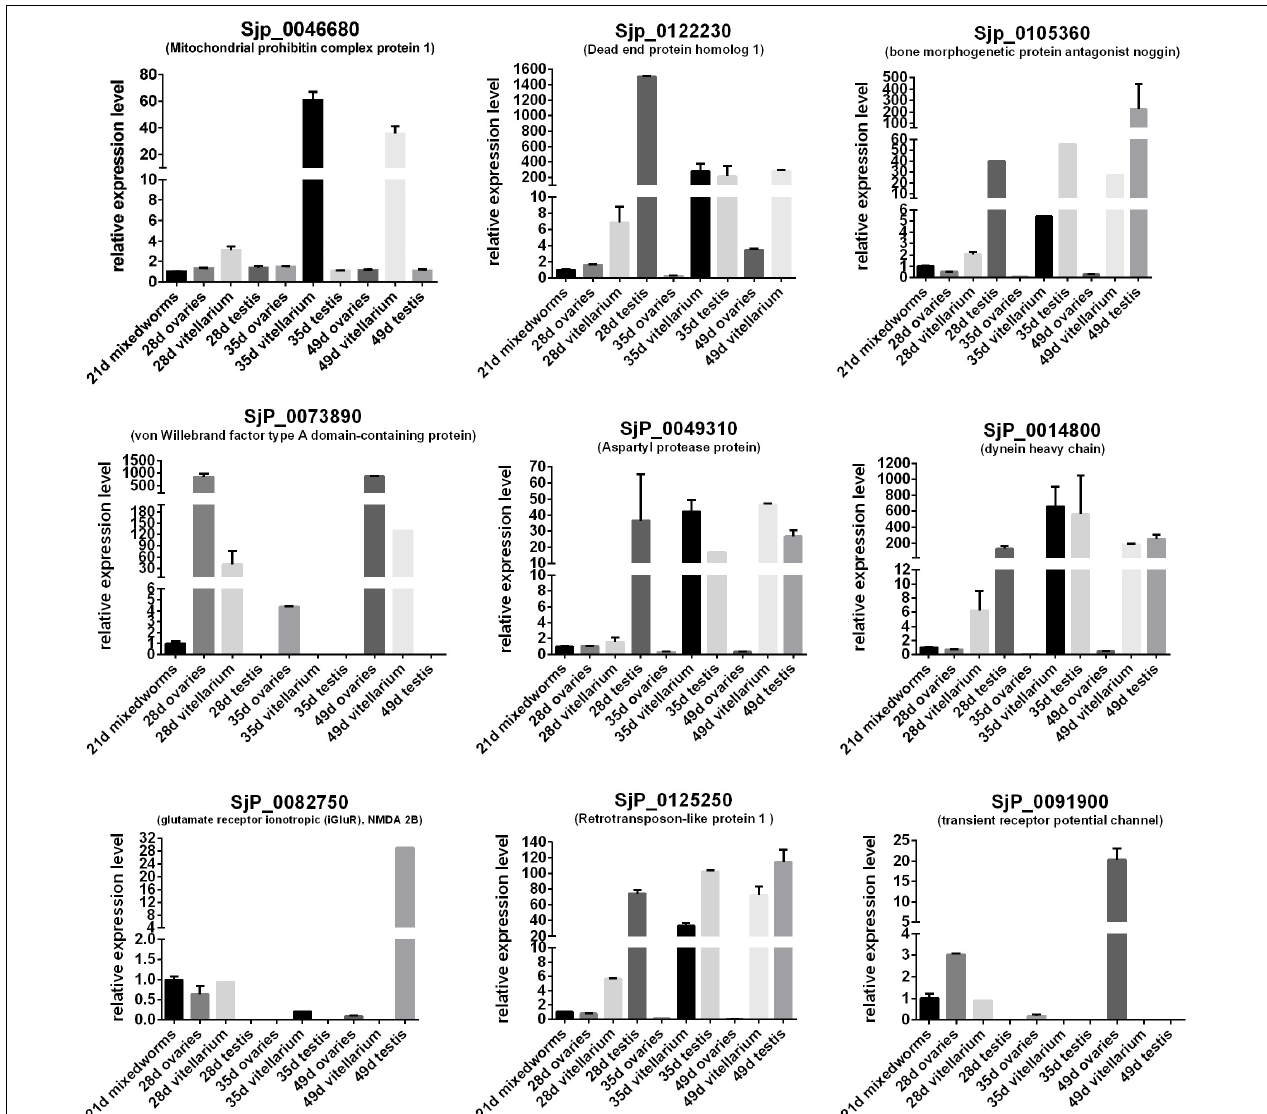
FIGURE 8 | Expression profiles of some differentially expressed genes of the worms with important biological significance in the gonads (ovary, vitellaria, and